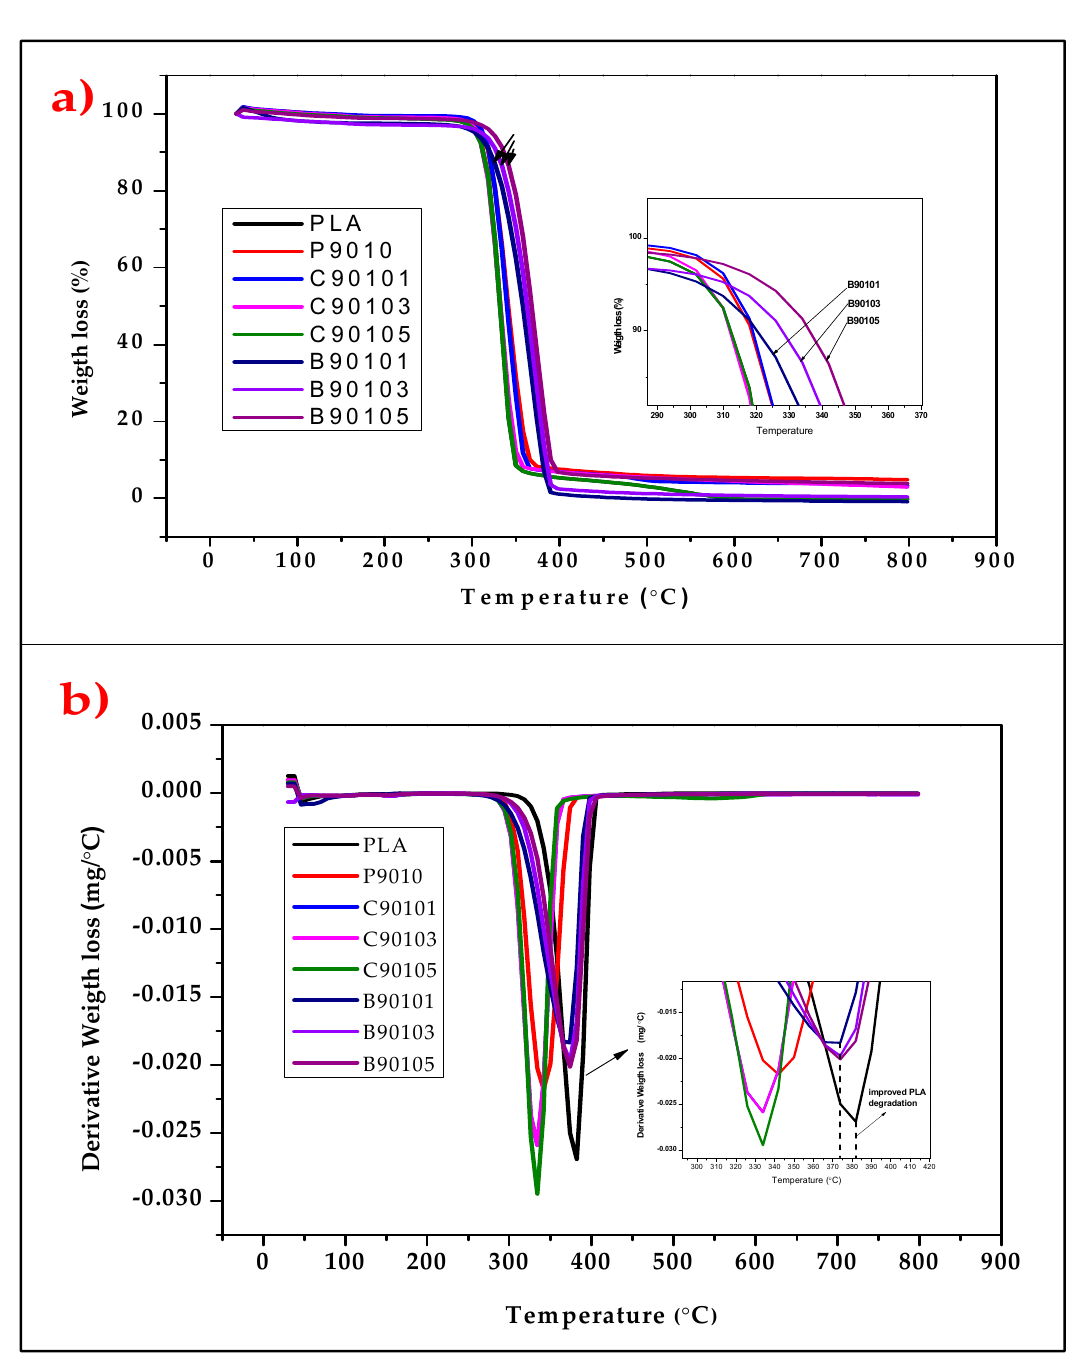
Figure 8. Comparative analysis of ( a ) TGA and ( b ) DTG properties of bamboo and commercial CNF ‐ reinforced biocomposites.